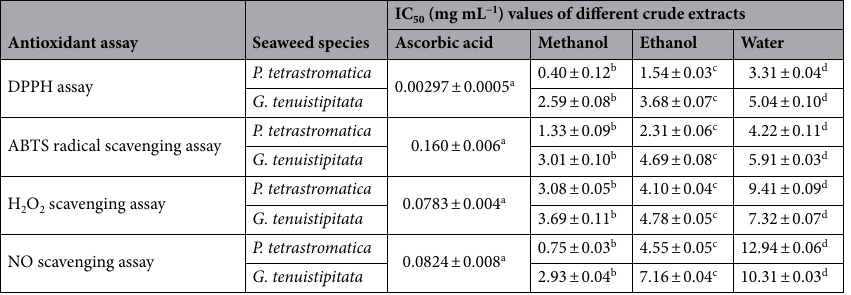
Table 4. Values of IC 50 (mg mL −1 ) resultant from various crude extracts of various antioxidant assays. Different superscript letters represent things that are substantially different from one another. Significance level is p <